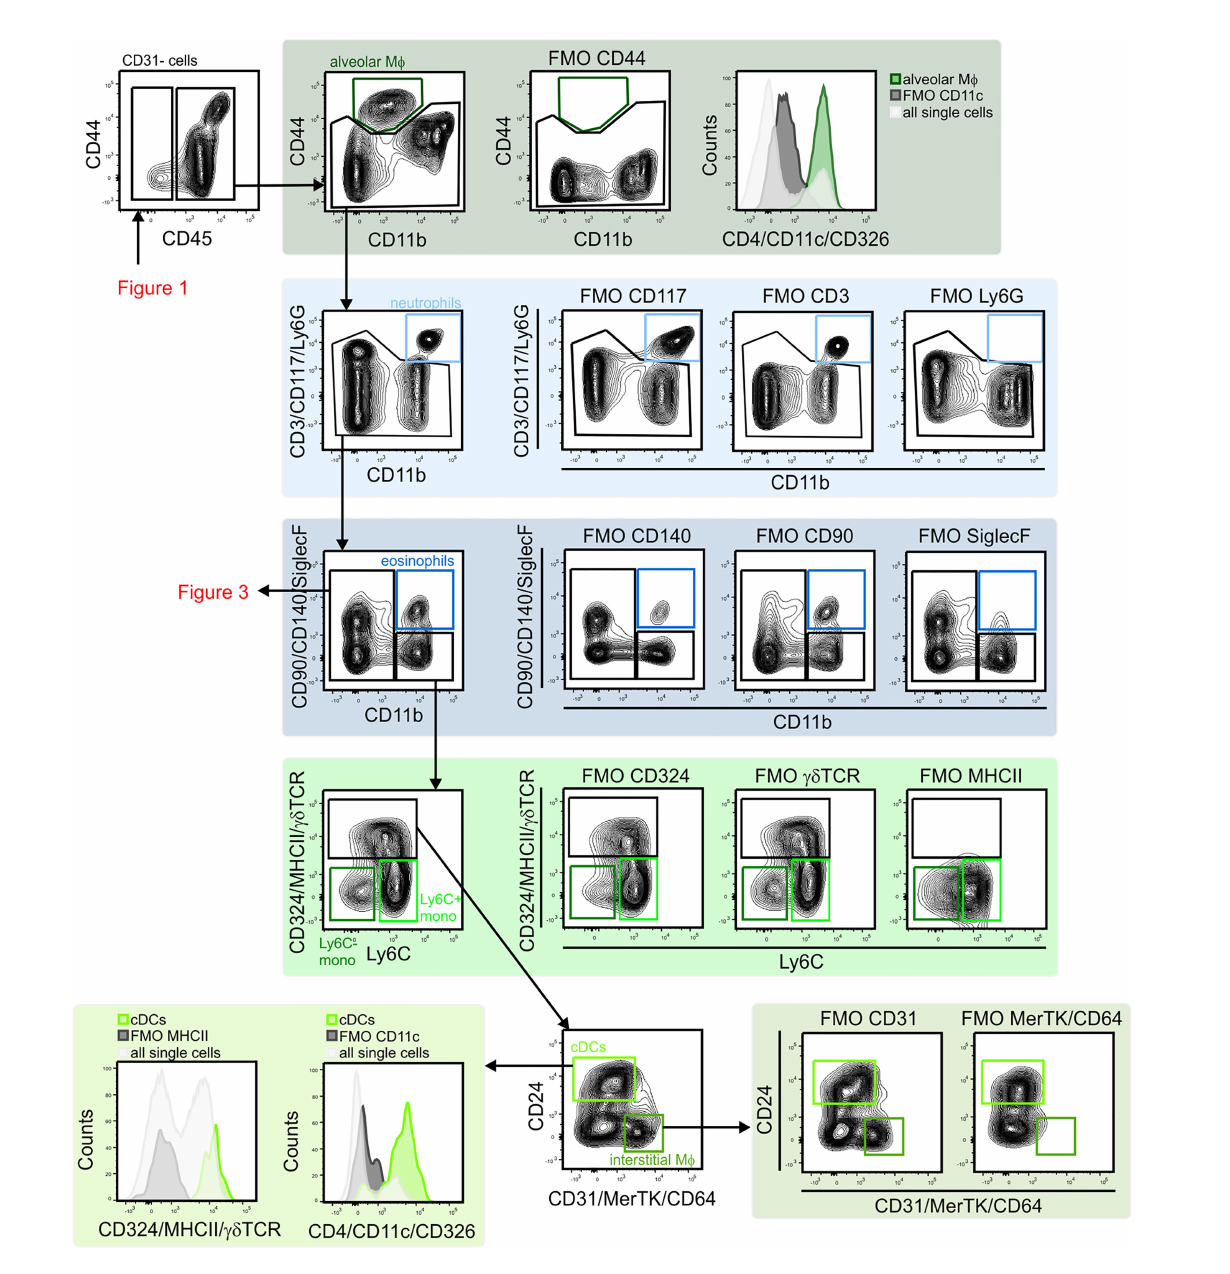
FIGURE 2 | Gating strategy for lung myeloid cells. The CD45 + population included alveolar macrophages (CD44 + /CD11b – /CD11c + ) were identi fi ed. CD11b expression was used to distinguish myeloid from lymphoid cells. The CD11b + population included neutrophils (CD11b + /Ly6G + ), eosinophils (CD11b + /SiglecF + ), monocytes (MHCII – /Ly6C + and MHCII – /Ly6C – ), cDCs (MHCII + /CD24 + ) and interstitial macrophages (MHCII + /CD24 – /CD64/MerTK + ) were identi fi ed. cDCs, conventional dendritic cells; FMO, fl uorescent minus one; Mono, monocytes; M Ф ,